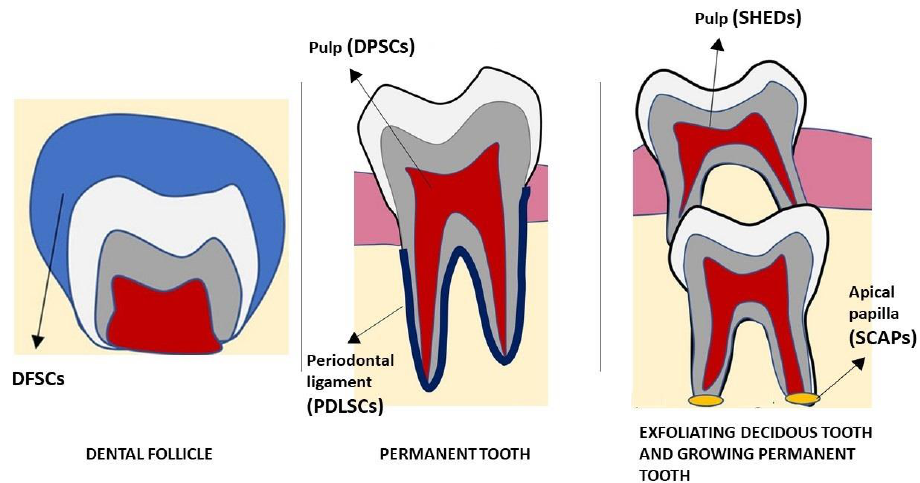
Figure 2. Dental tissues where dental derived stem cells can be harvested. The dental follicle is the niche of DFSCs, the permanent tooth houses the following mesenchymal stem cells: DPSCs in the pulp; PDLSCs in the periodontal ligament; SCAPs in the apical papilla. The pulp of exfoliated deciduous teeth house SHEDs.